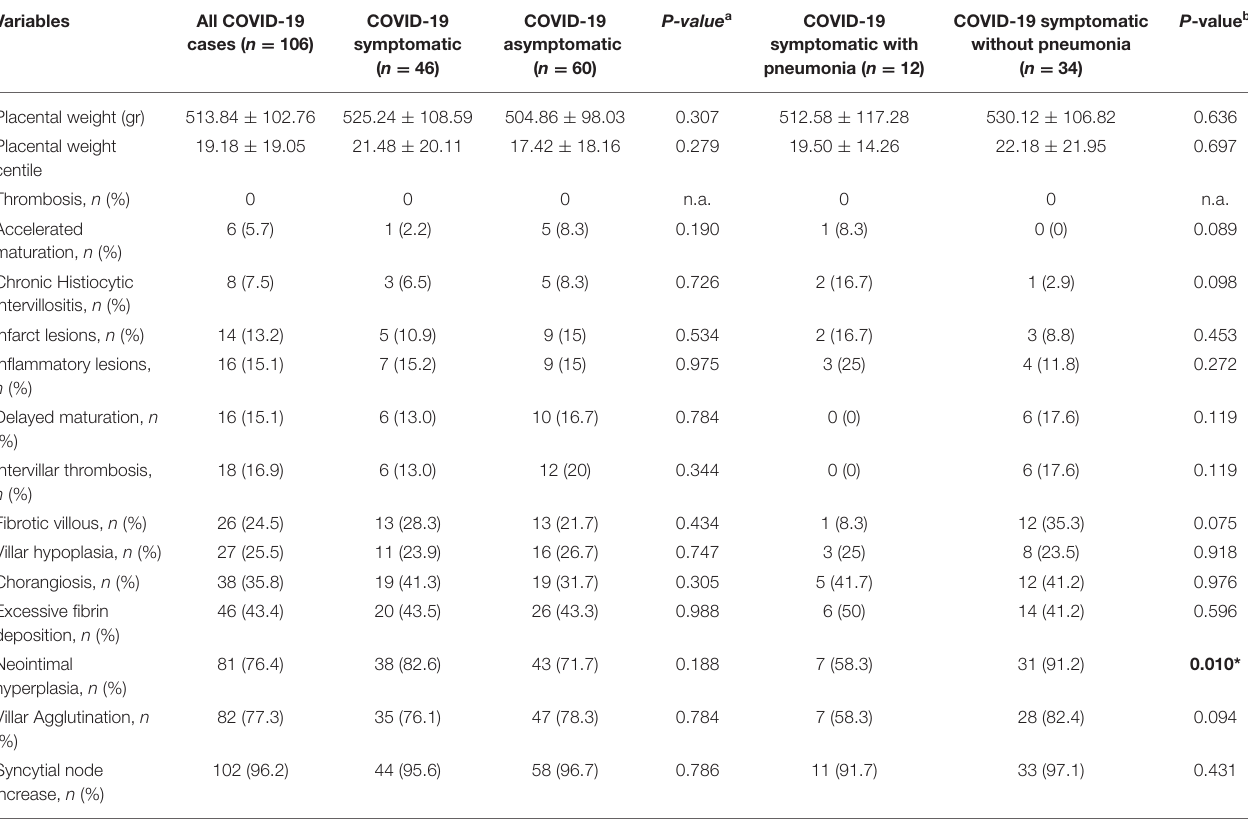
TABLE 2 | Placental histopathological findings of all COVID-19 placental tissues according to COVID-19 symptomatology and diagnosis of pneumonia.